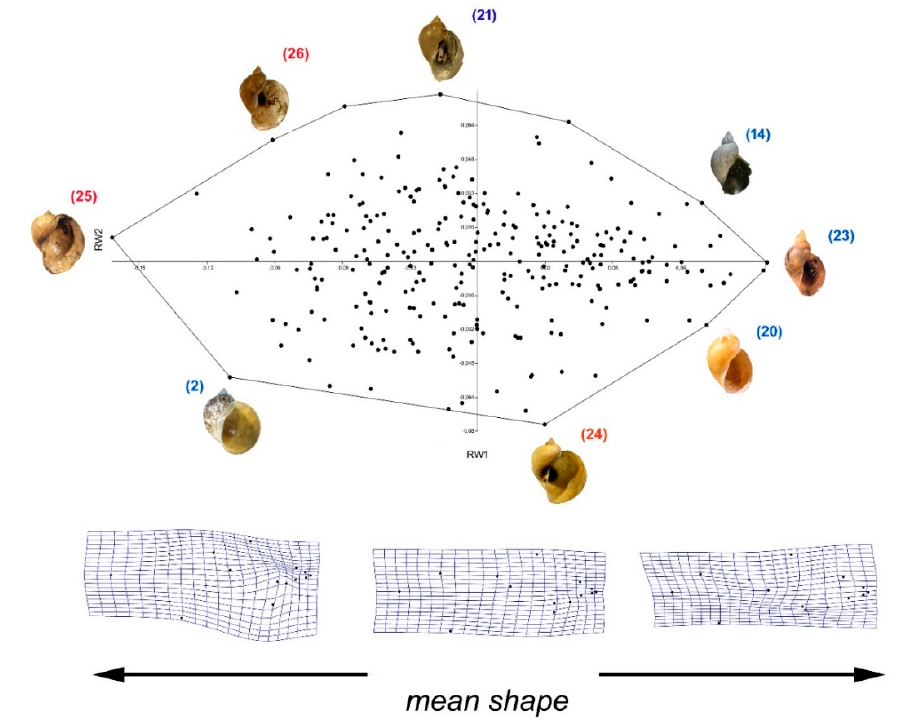
Figure 11. ( Above )—continuous morphospace of Radix auricularia based on the results of geometric morphometric analysis. ( Below )—thin-plate spline deformation grids illustrating phenotypical variation along axes of the reconstructed morphospace. Shell images (sizes not to scale) illustrate specimens located at the extreme points of the convex polygon containing all points. Numbers in brackets correspond to numbers of populations in Table 1. Red numbers designate non-Baikalian and blue numbers Baikalian